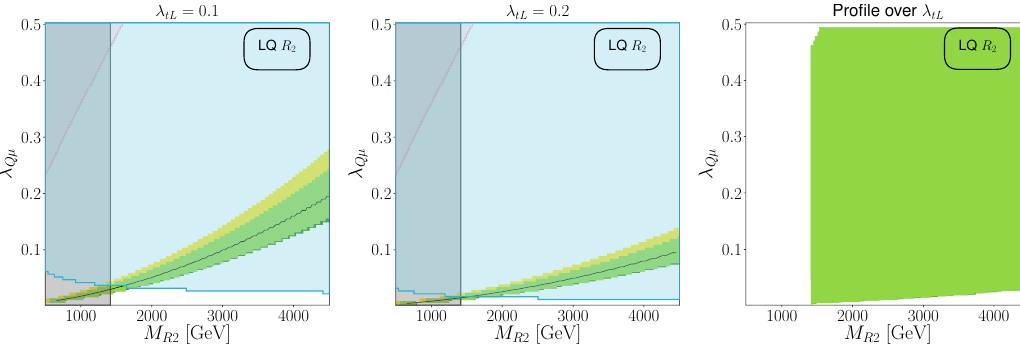
and/or ∆ a 2021 in the model with a scalar leptoquark Figure 3. Scenarios which can explain ∆ a BNL µ µ SU(2) doublet R defined in eq. (3.5). Results are shown in the M - λ plane for fixed λ = 0 . 1 L 2 R 2 QL tL (left panel), λ = 0 . 2 (middle panel) and by varying λ [0 , 0 . 5] (right panel). In the latter case tL tL ∈ we profile to find the regions in the M - λ plane where these measurements can be explained R 2 QL for some value of λ in the scan and satisfy experimental constraints. Colours are the same as in tL figure 2. Additional relevant exclusions in the parameter space from the constraint Z → νν are shaded in pink and in the right panel this is included in the list of experimental constraints that points must satisfy, in addition to those listed in figure